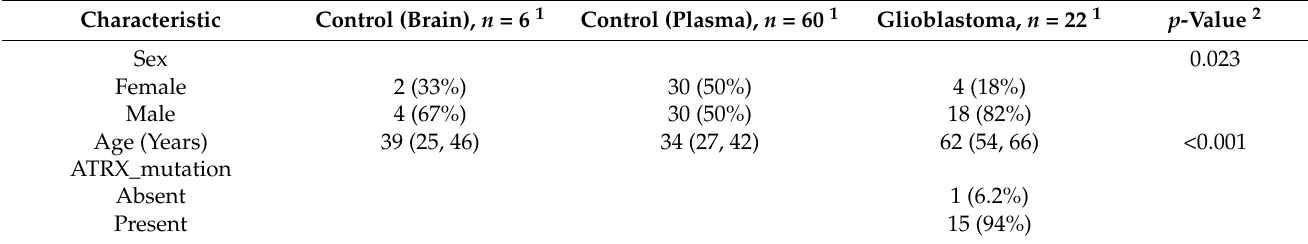
Table 1. Main cohort